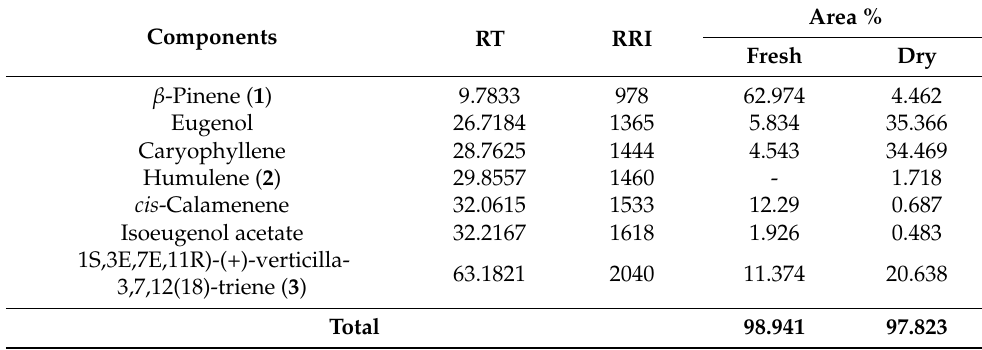
Table 2. Components of fresh and dried stem samples essential oil of C. gileadensis